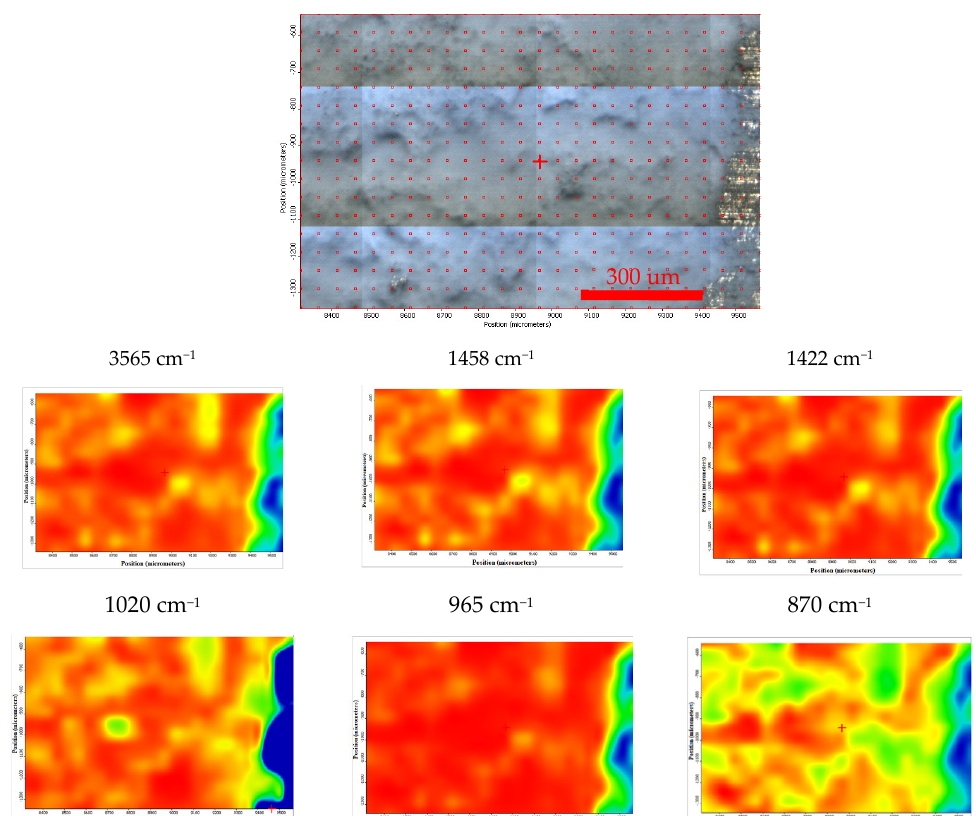
Figure 8. Chemigram maps of the coated ZM 21 alloy. In the upper part, a dark field optical image, corresponding to the investigated area, is presented. In the lower part, false colour maps with the indicated reference bands are shown. The chemigram scale bars are expressed in µ m.